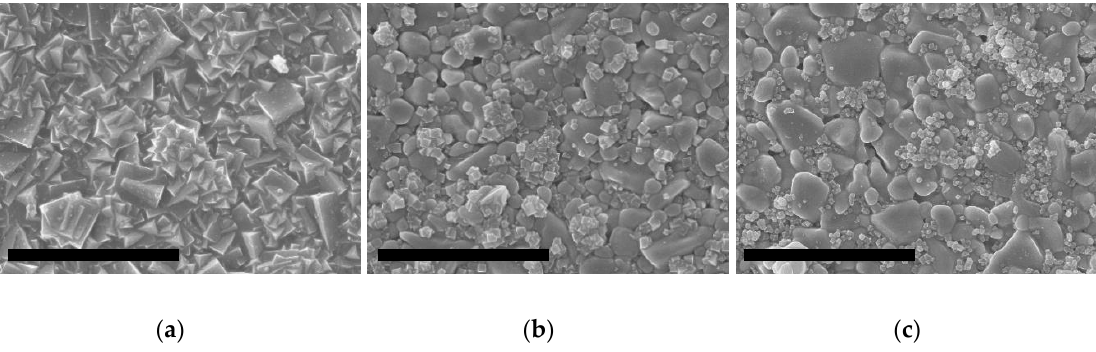
Figure 5. SEM images of the materials grown on the alumina supports from gels of different H 2 O/SiO 2 molar ratios: ( a ) 5; ( b ) 7; ( c ) 13. Scale bars correspond to 30 µm.